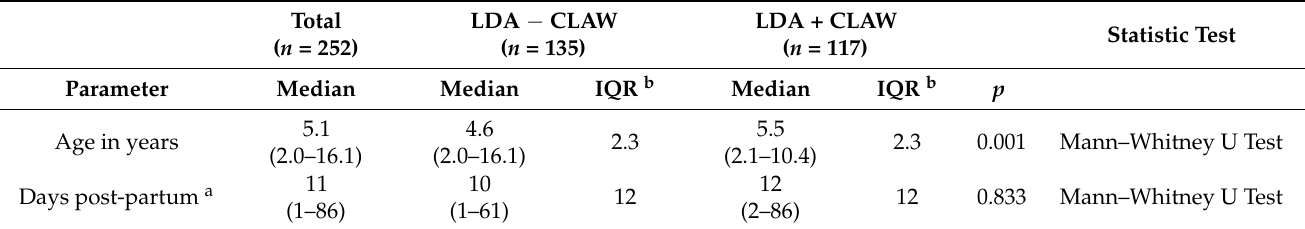
Table 1. Distribution of age and days post-partum of animals diagnosed with left displacement of the abomasum (LDA) and either no claw lesion (LDA − CLAW) or at least one claw lesion (LDA + CLAW). Results with a p -value < 0.05 were considered statistically significant and are printed in bold letters. As data was normally distributed, mean and standard deviation (SD) are given.